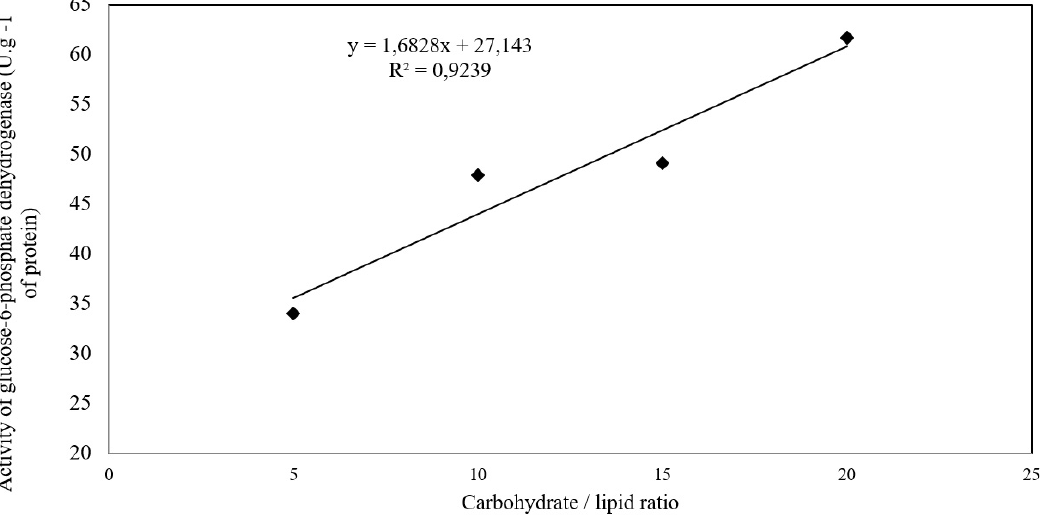
Figure 1 - Linear regression of the hepatic glucose-6-phosphate dehydrogenase activity of the juvenile Pseudoplatystoma ssp. fed the experimental diets for 60 days (n=18).